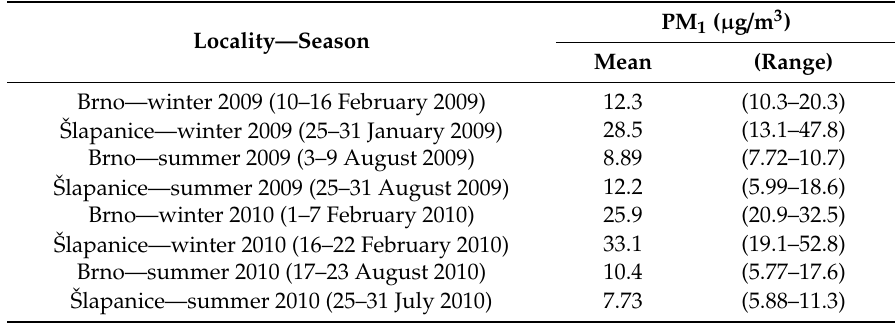
Table 2. Mass concentrations of PM 1 aerosols during the